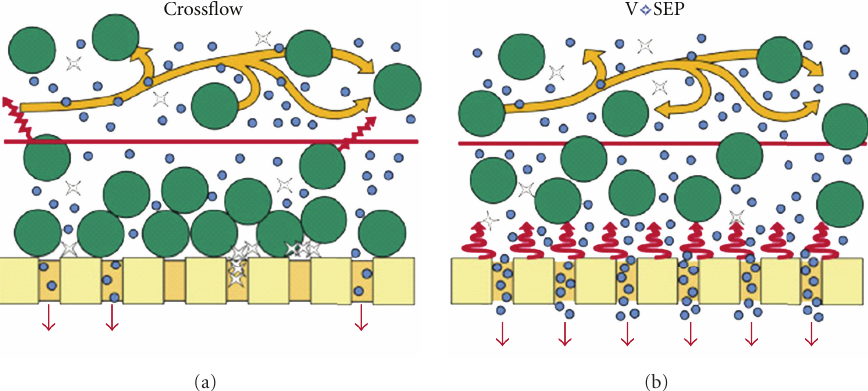
Figure 2: A Comparison of conventional treatment methods and VSEP: a vibrating membrane filtration system, VSEP treatment of RO reject from brackish well water [8].